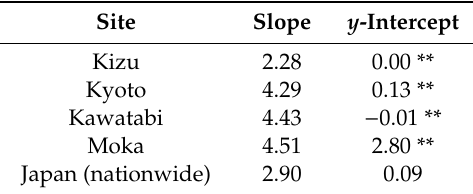
The slopes at farm scale were not significantly different from the slope of the nationwide samples excluding volcanic ash soils (Japan (nationwide)). ** indicates the significant difference from Japan (nationwide) at p < 0.01 (ANCOVA).